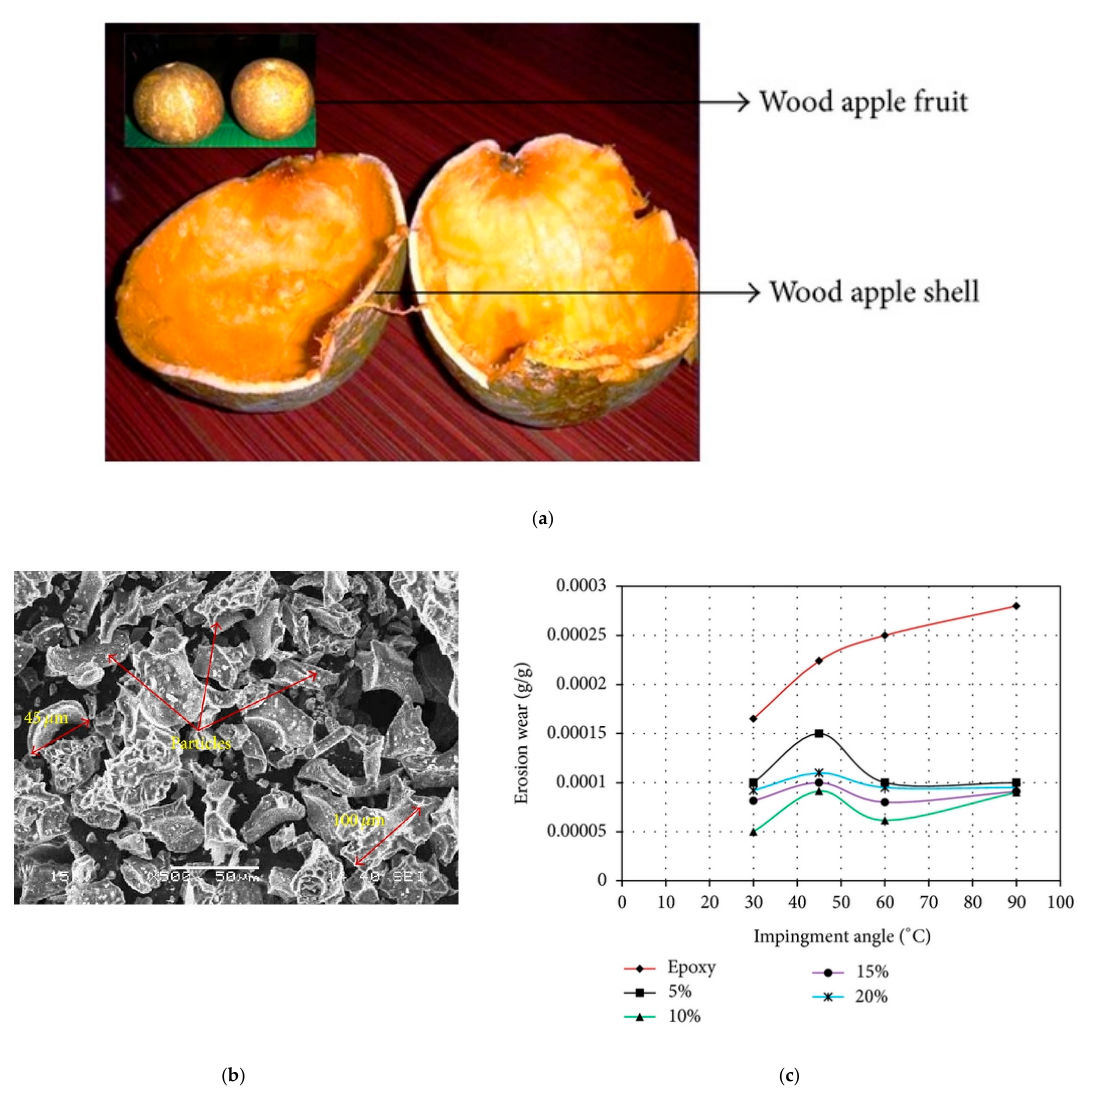
Figure 5. ( a ) Photograph of wood apple fruit and wood apple shell, ( b ) SEM images of the wood apple shell particles, ( c ) erosion wear behavior of the composites at different impingement angles [45]. Open